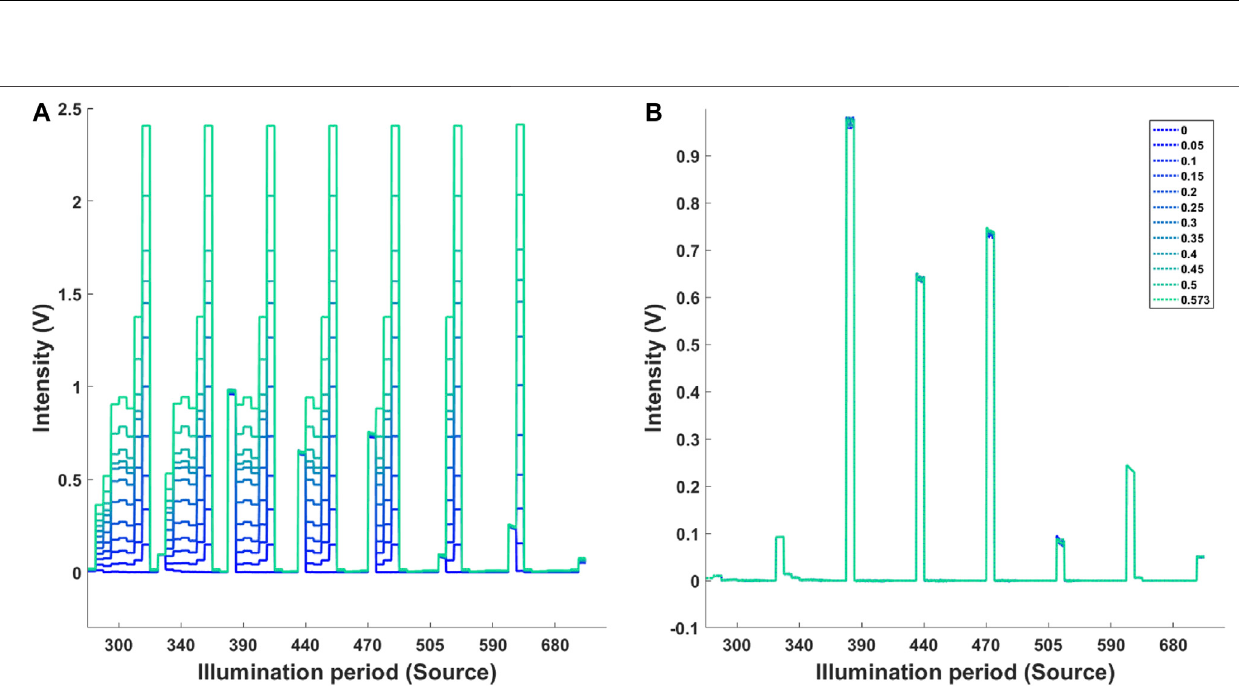
Frontiers in Physics |